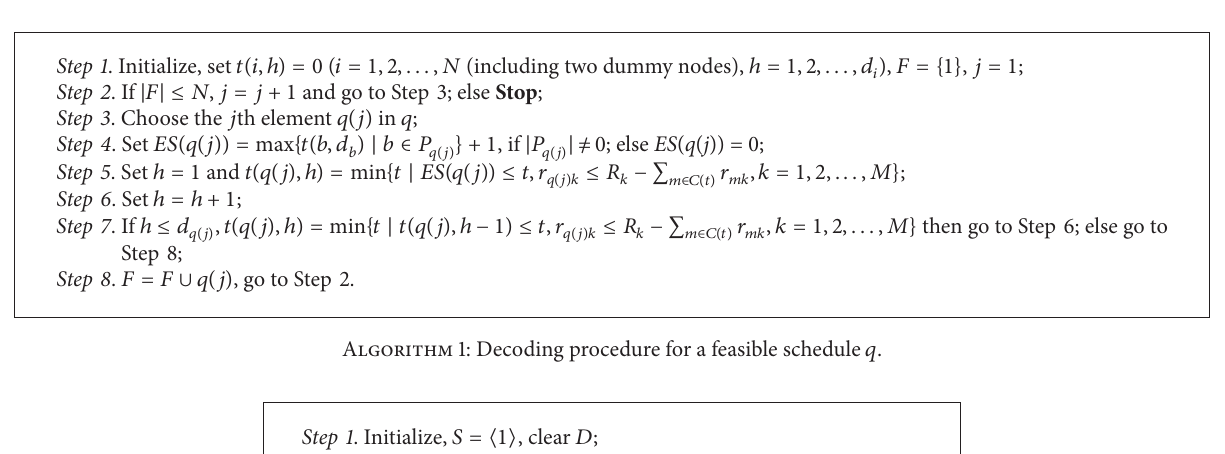
Figure 4: Optimal Gantt chart of RCPSP PA.